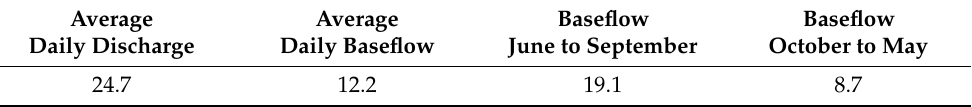
Table 2. Characteristics of daily discharge and baseflow in the Zhulong river watershed (m 3 /s).